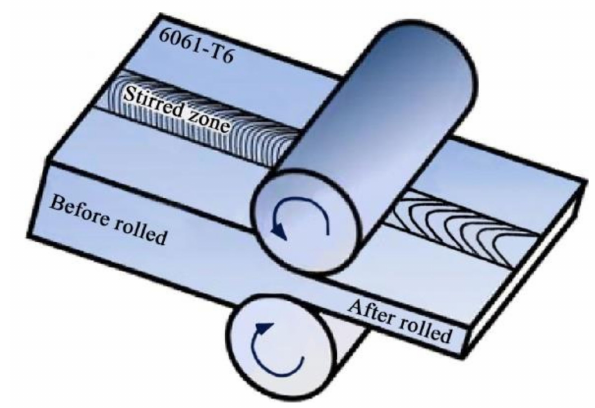
Figure 23. Schematic diagram of post-weld entire rolling [58].